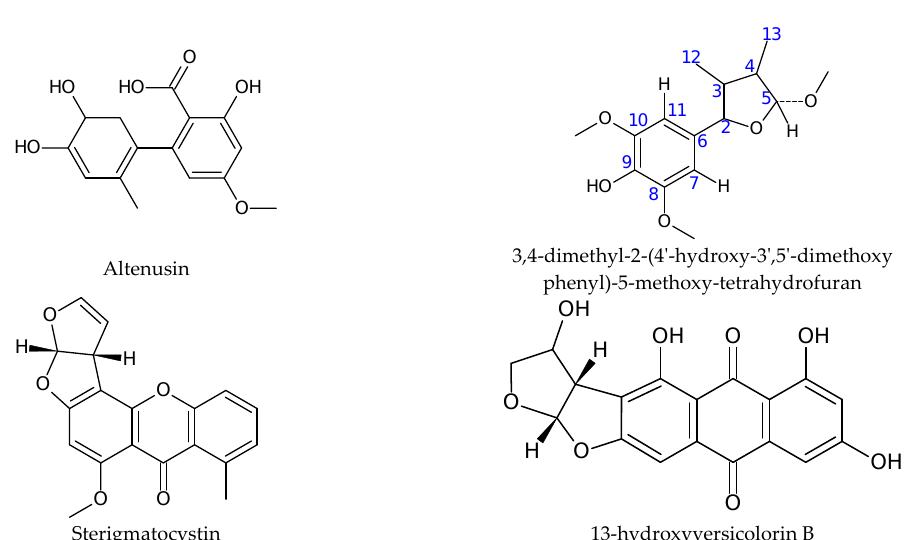
Figure 5. The molecular structure of chosen specific compounds with antiparasitic activity synthesized by fungal endophytes associated with Asteraceae species [91,108,112].